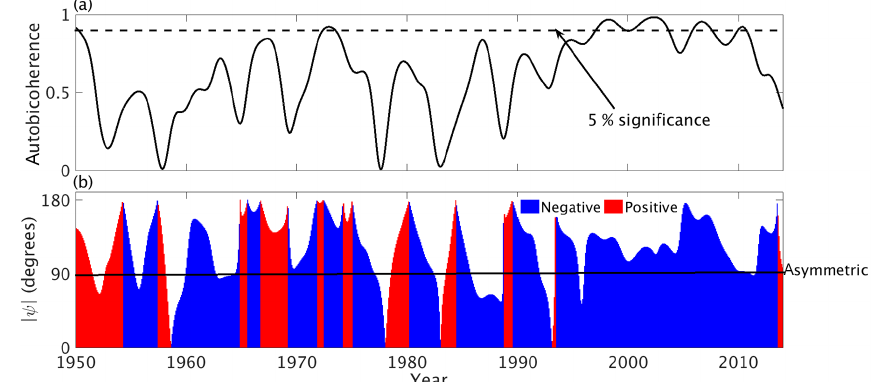
Figure 9. Same as Fig. 8 except at the point (16, 26).